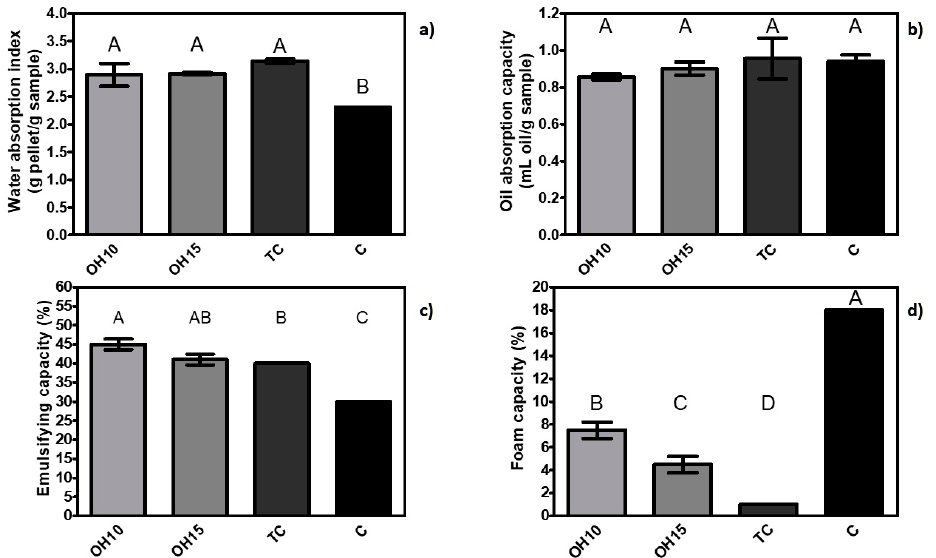
Figure 1. Techno-functional properties of bean flour processed by ohmic heating (OH10: 110 ◦ C/10 min, OH15: 110 ◦ C/15 min) and traditional processing (TC). Each value represents the mean of two replicates ± DS. Values with the same letter are not different from each other (Tukey α = 0.05).